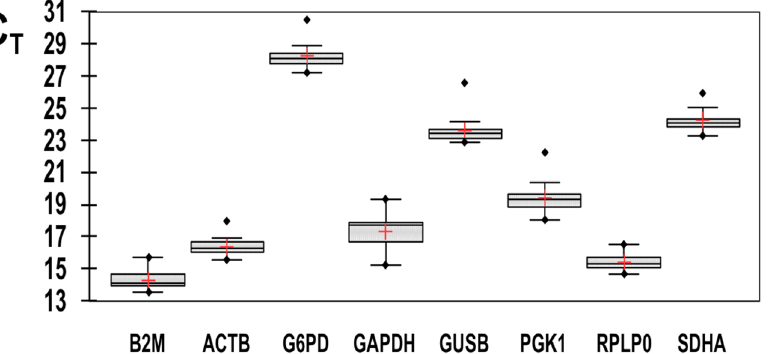
Figure 3. Distribution of CT values for candidate reference genes in red deer blood samples. Boxes: range of CT values; black center line: median CT; cross: mean score; upper and lower hinges: 75 and 25 percentiles; whiskers: largest/smallest CT values within 1.5 times IQR (Interquartile range) from the upper and lower hinges.